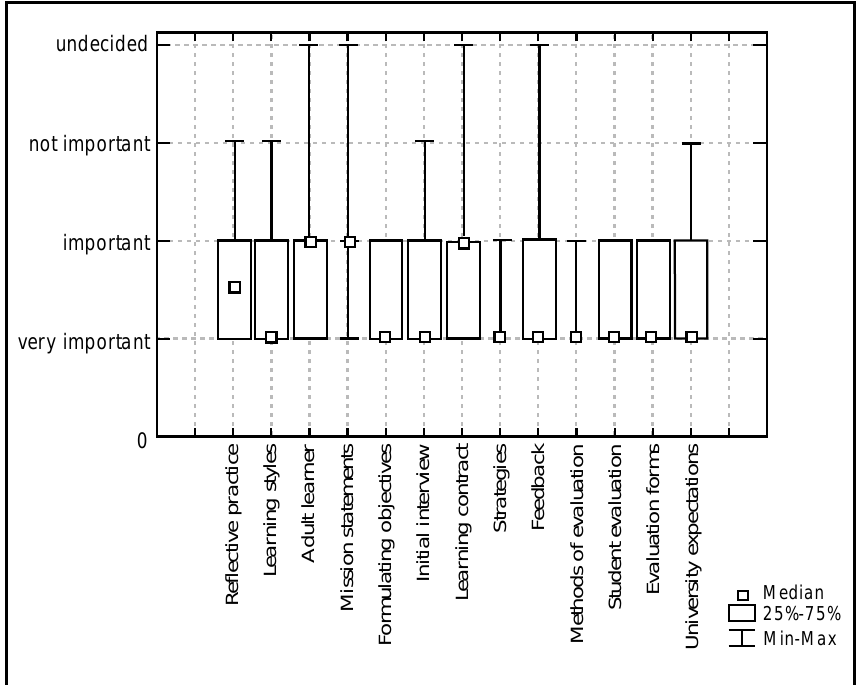
Figure 4: Participants’ perception regarding the importance of the topics